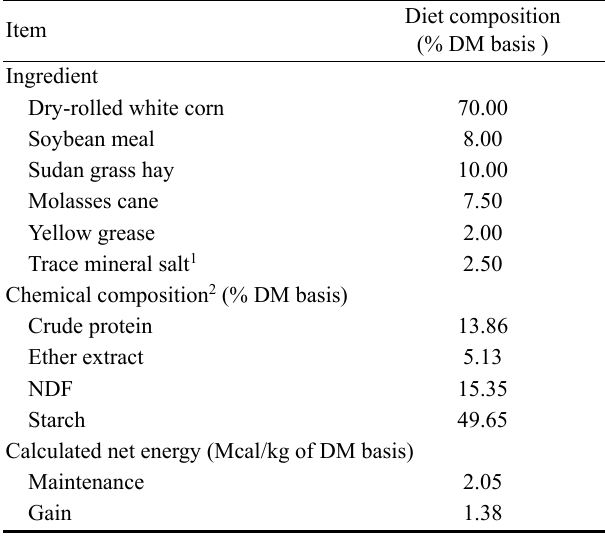
Table 1. Ingredients and composition of basal diet fed to ewe (% of dry